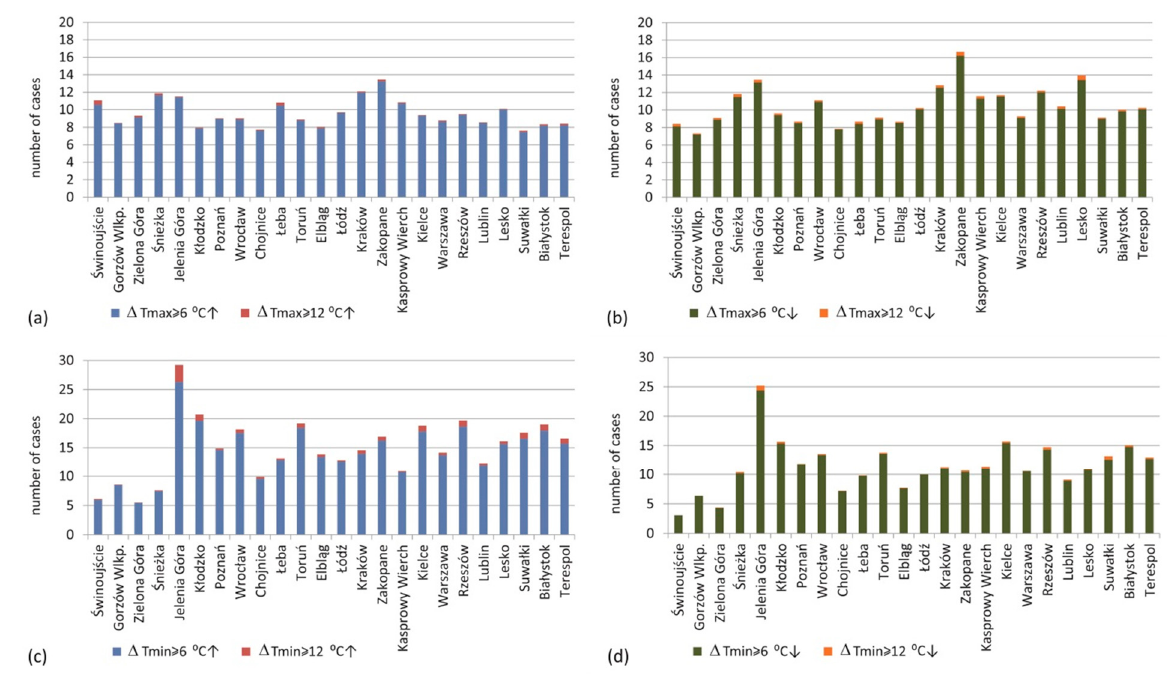
Figure 5. Mean annual number of cases of large and very large day-to-day increase ( ↑ ; ( a , b )) and decrease ( ↓ ; ( c , d )) in Tmax and Tmin in Poland in years 1966–2015 (stations ordered according to their longitude).